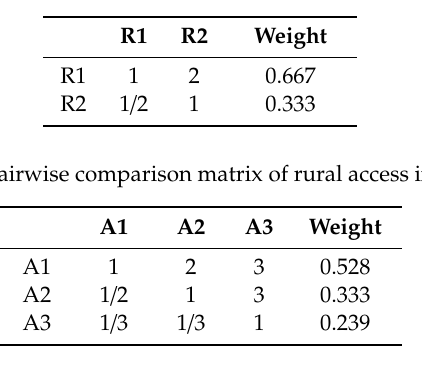
Table A8. Pairwise comparison matrix of rural resources indicators.